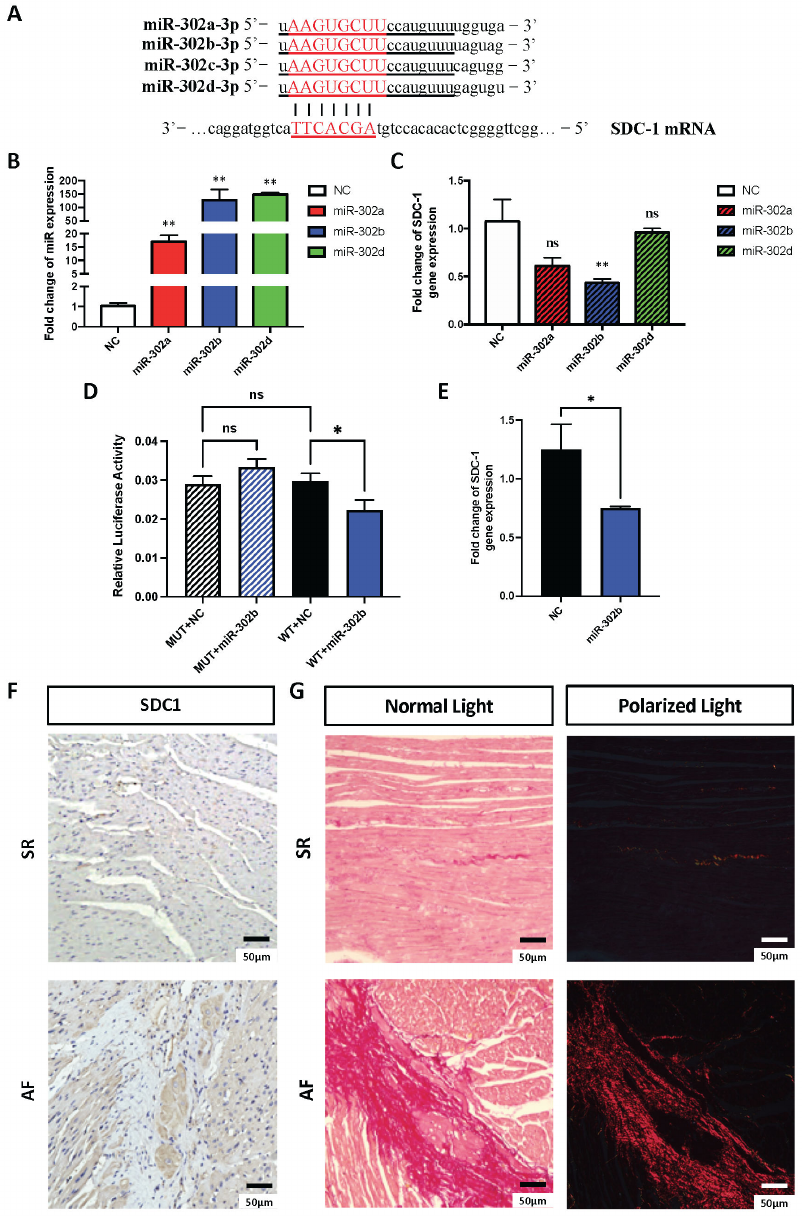
Figure 7. miR-302-3p may regulate atrial fibrosis by targeting the expression of SDC-1. ( A ) Conserved sequences of miR-302 family. Underlined sequences indicate conserved nucleotides including